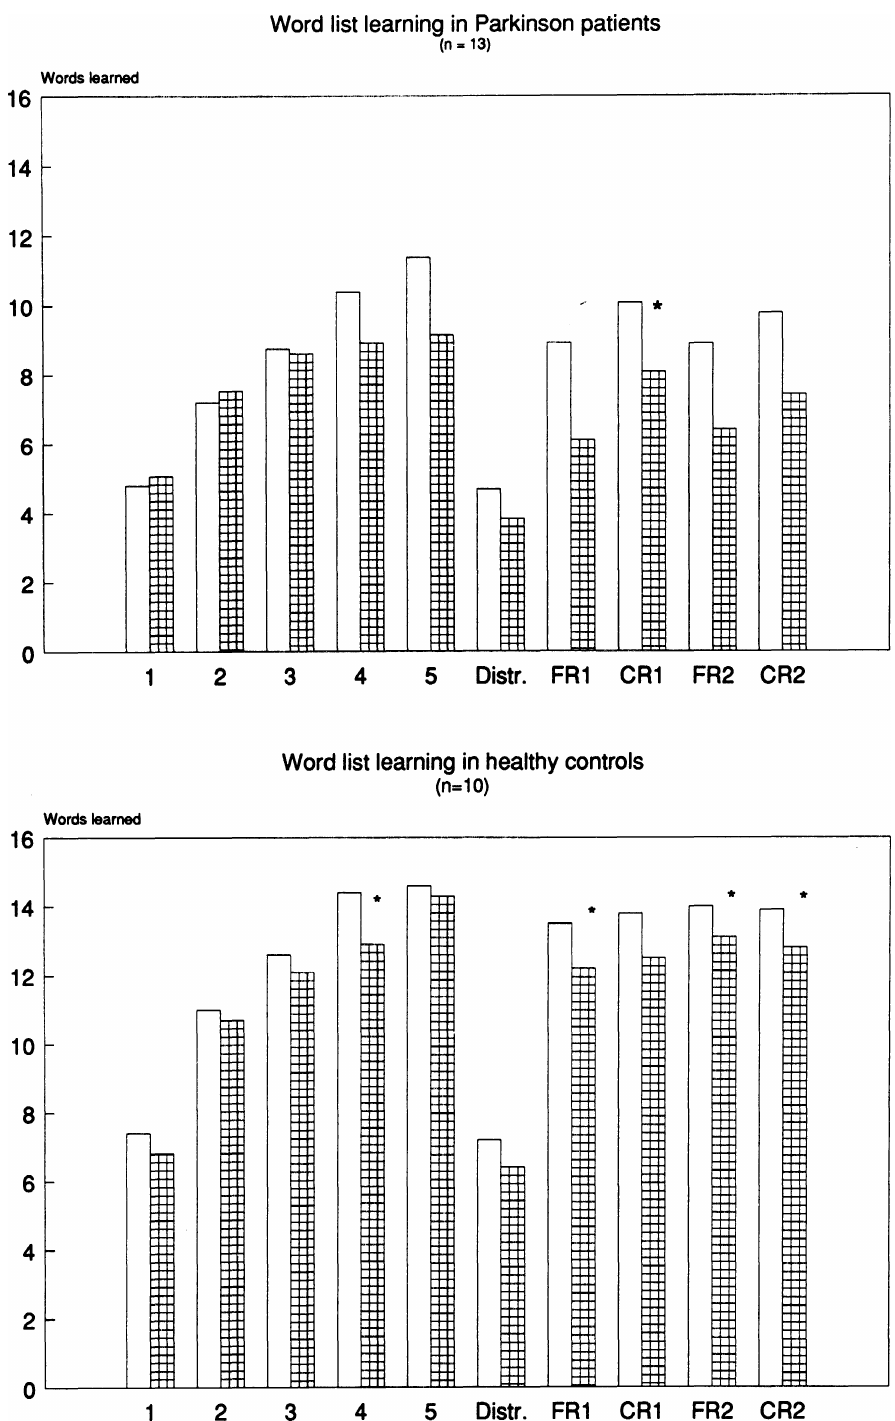
FIGs. ! and 2. Word list learning as assessed by means of CVL T. 1--5: learning during five repetitive presentations. Distr.: Learning of distractor list.FR l/CR!: free/cued recall of first list immediately after distractor list, FR2/CR2: free/cued recall of first list after 20 min. Open bars: pretreatment phase; hatched bars: treatment phase. *p <